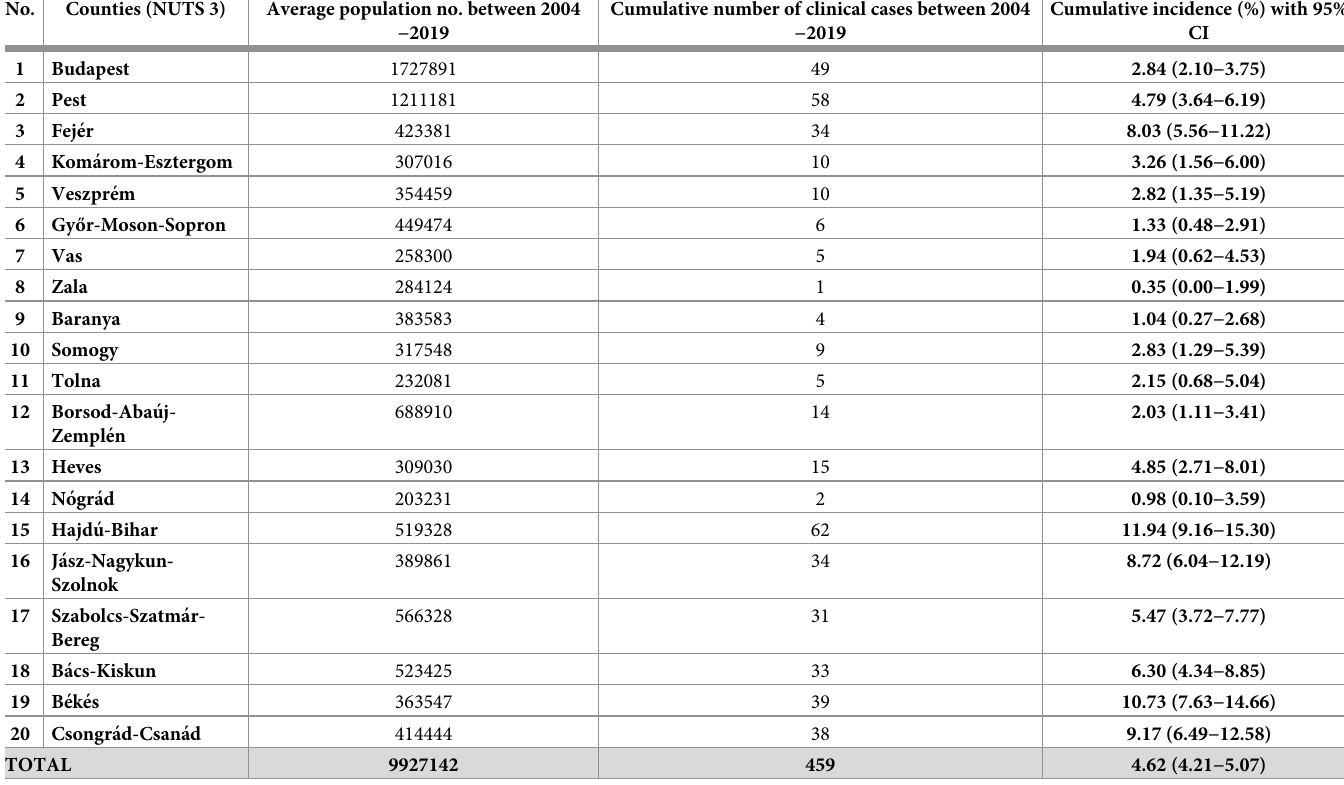
Table 3. West Nile virus cumulative incidence data between 2004 and 2019, at NUTS 3 level in Hungary.